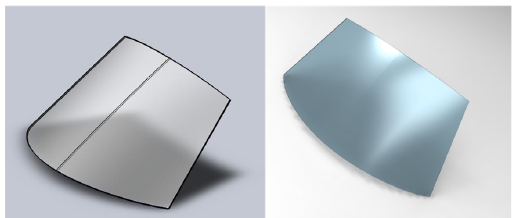
Figure 2: 3-D model for or the windshield surface we used a publicly available open-source 3-D model of a Mazda MX- 5 Miata, 2002 form https://grabcad.com/library/mazda-miata-